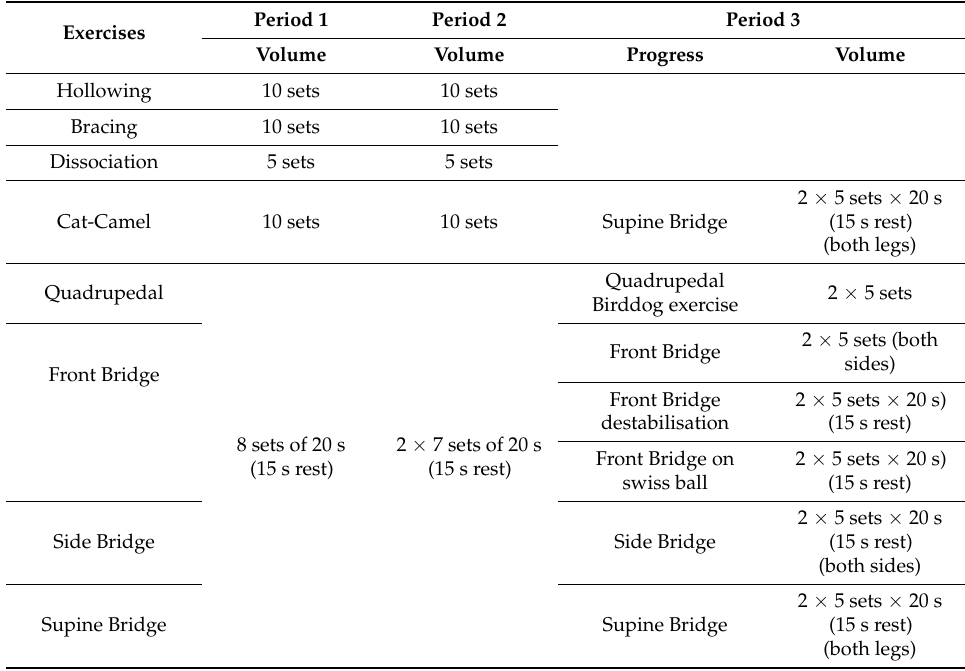
Table 2. The Core